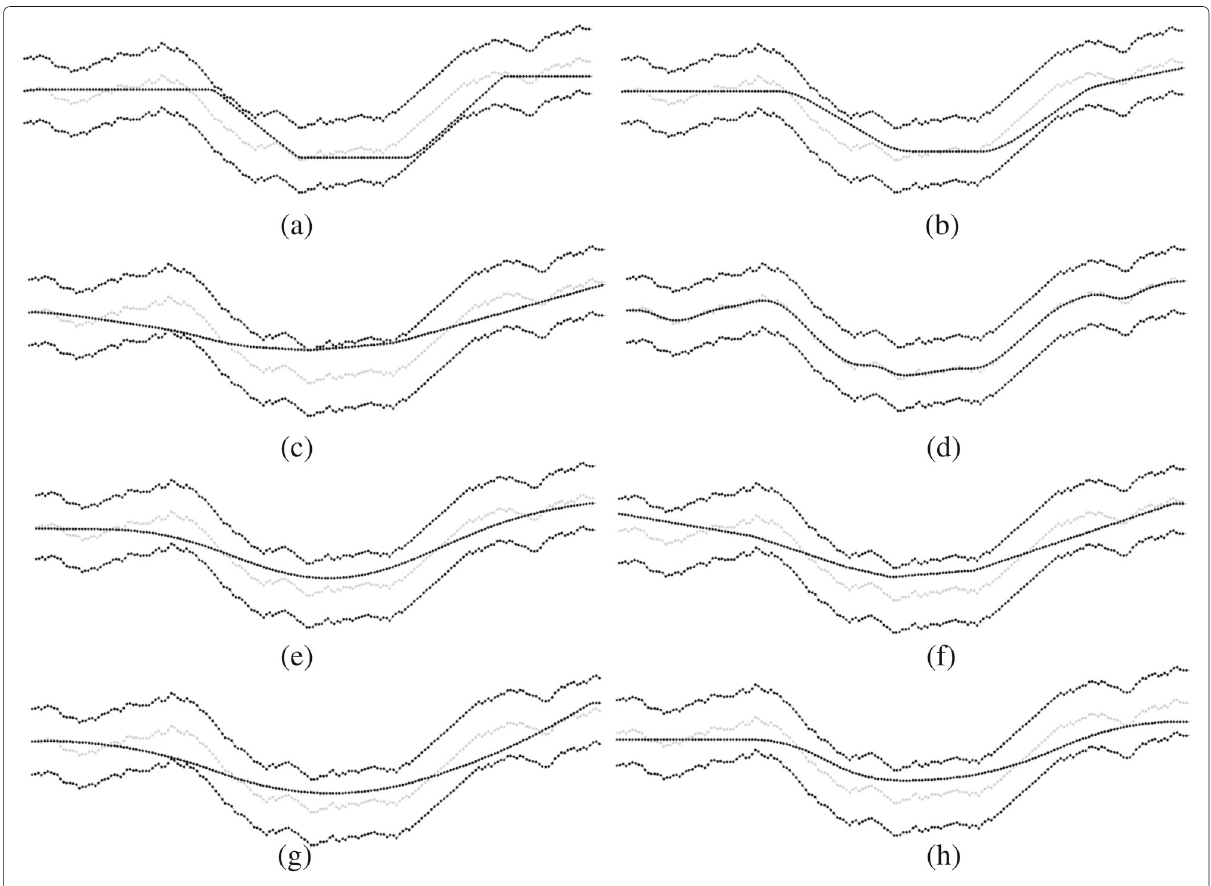
Fig. 15 Performance comparison of the proposed algorithm with [36]. a P 2,20% ( K = 2, image margin 20%), b P 10,%20 ( K = 10, image margin 20%), c P 60,20% ( K = 60, image margin 20%), d LPF 10 ( K = 10, low-pass filter), e LPF 60 ( K = 60, low-pass filter), f [36], w 2 = 1, w 1 = w 3 = 0, g [36], w 3 = 1, w 1 = w 2 = 0, and h [36], w 1 = 10, w 2 = 1, w 3 = 100. Weights for the proposed algorithm are set at (0.01, 0.01, 10)